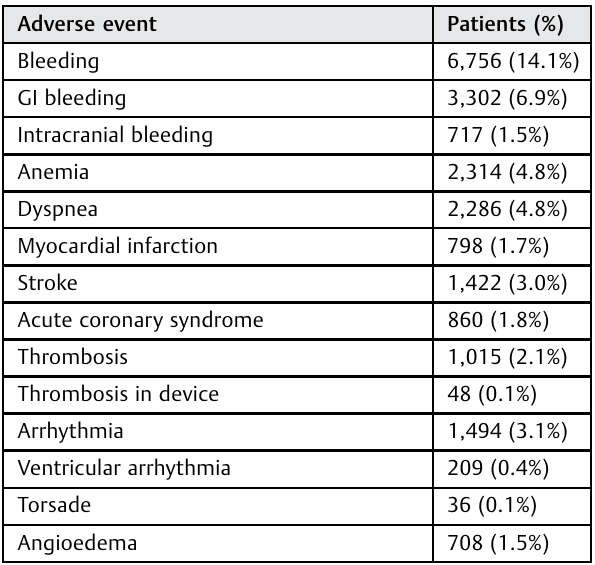
Abbreviations: FAERS, Food and Drug Administration Adverse Event Reporting System; GI,